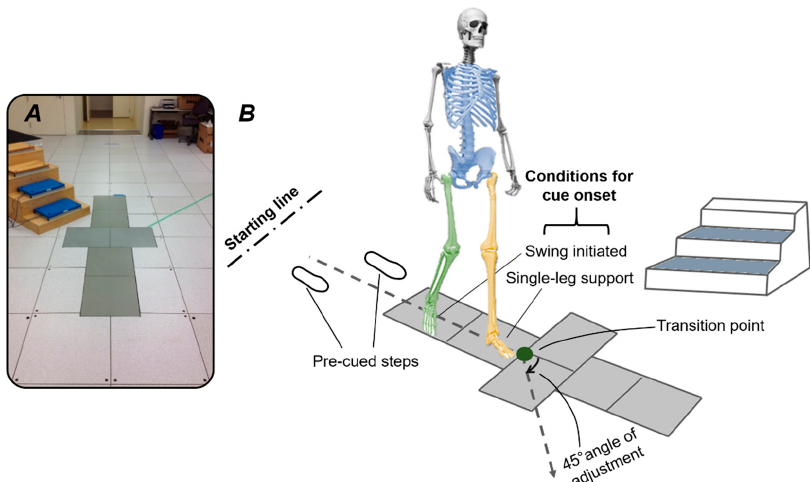
Figure 1. Experimental setup for the locomotor tasks. ( A ) Lab setup for straight walking, sidestep and crossover cuts, and cuts to stair ascent performed under varying task anticipation. ( B ) The transition point and path for cut transitions were shown on the walkway. Each trial was initiated with the first trailing leg heel strike. Subjects entered a locomotor transition at the first trailing leg toe o ff , and transition ended with the second trailing leg heel strike. Unanticipated trials were recorded when a randomized cue was given half a step prior to the marked transition point on the terrain. Di ff erent signal locations, including the trailing leg, leading leg, and trunk-pelvis were indicated with green, yellow and blue,